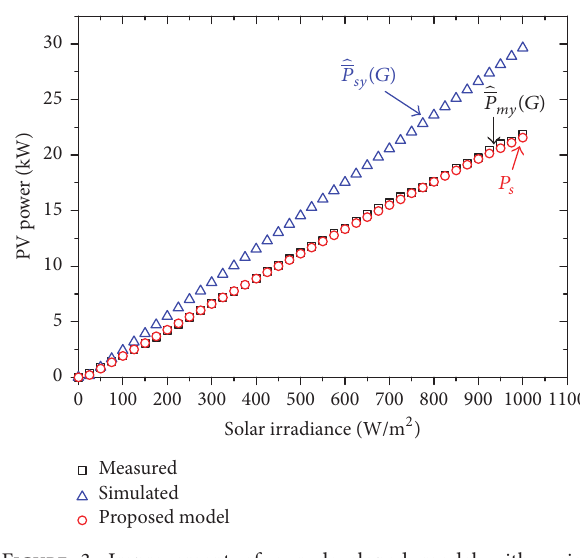
Figure 3: Improvement of our developed model with weight